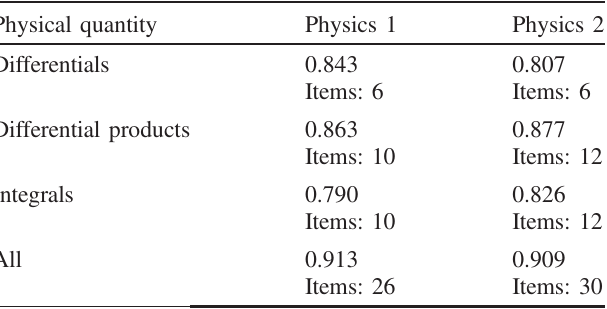
TABLE II. Assessment reliability statistics. Cronbach ’ s α is shown for both the Physics 1 and Physics 2 populations for each set of assessment items. Below each Cronbach ’ s α , we show the number of items for each physical quantity from both assessments.